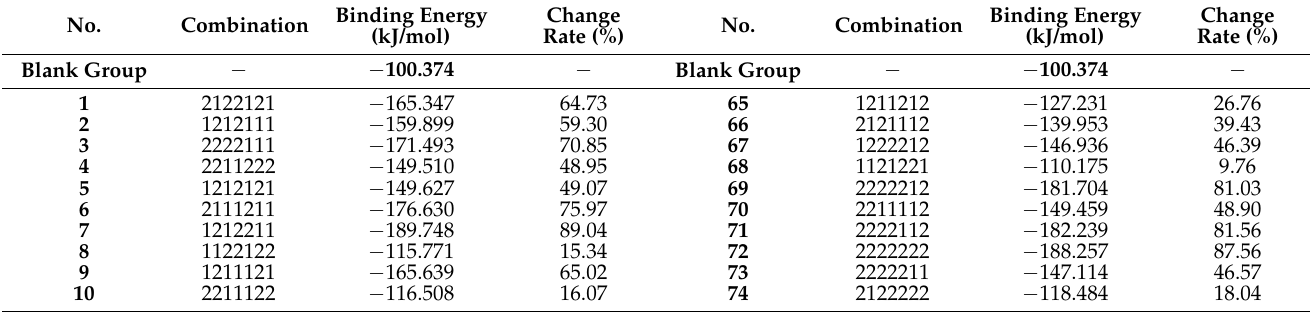
Table 3. The proportioning strategy for plastic components is based on a full factorial experimental design and the binding energies of the components with breakdown proteins